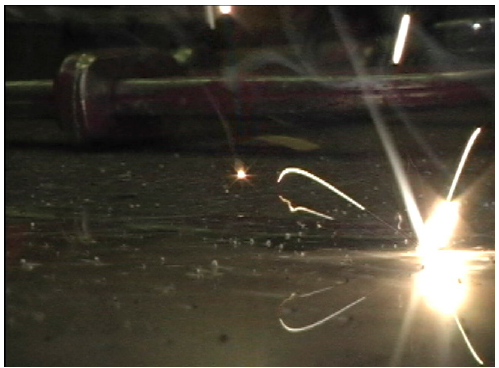
Figure 19. Apparent fragmentation of ignited aluminum particles on impact with SS plate.